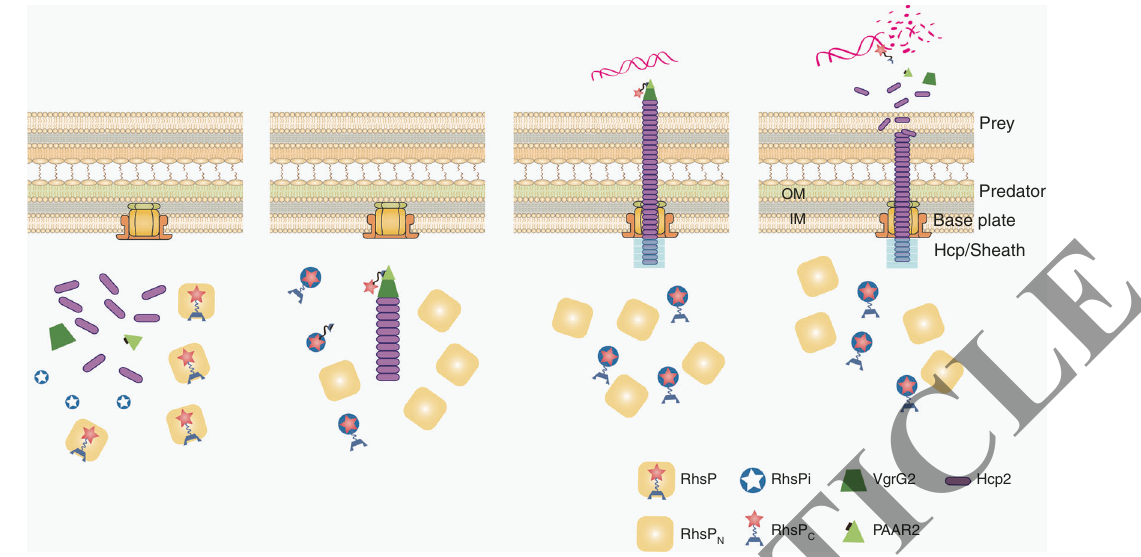
Fig. 7 Schematic model for the secretion mechanism of pro-effector. Pro-effector (such as RhsP) encapsulates the effector domain (RhsP C ) upon expression. RhsP C is released through auto-proteolysis inside cells before secretion, and eventually binds to PAAR (PAAR2 in V. parahaemolyticus ) through PID. Immunity protein (such as RhsPi) could protect RhsP C from degrading the genomic DNA of bacteria that produce it upon its release from pro-effector. PAAR could also have weak association with effector domain before its release. PAAR-effector complex will be delivered by T6SS during TssB/TssC sheath contraction. Toxic effectors injected damage the target cells that do not express or express low level of immunity proteins (such as degradation of genomic DNA by RhsP C